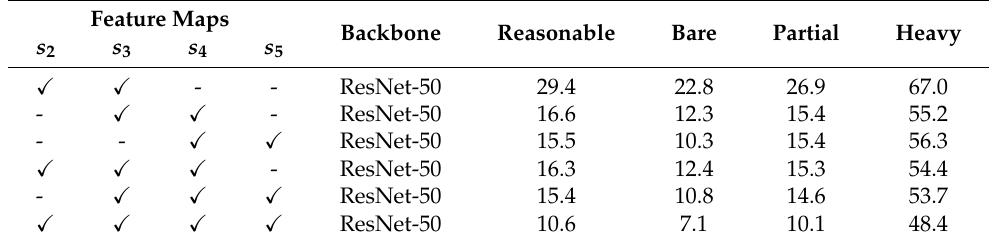
Table 2. Ablation study analysis of different combinations of multi-scale feature on the Citypersons